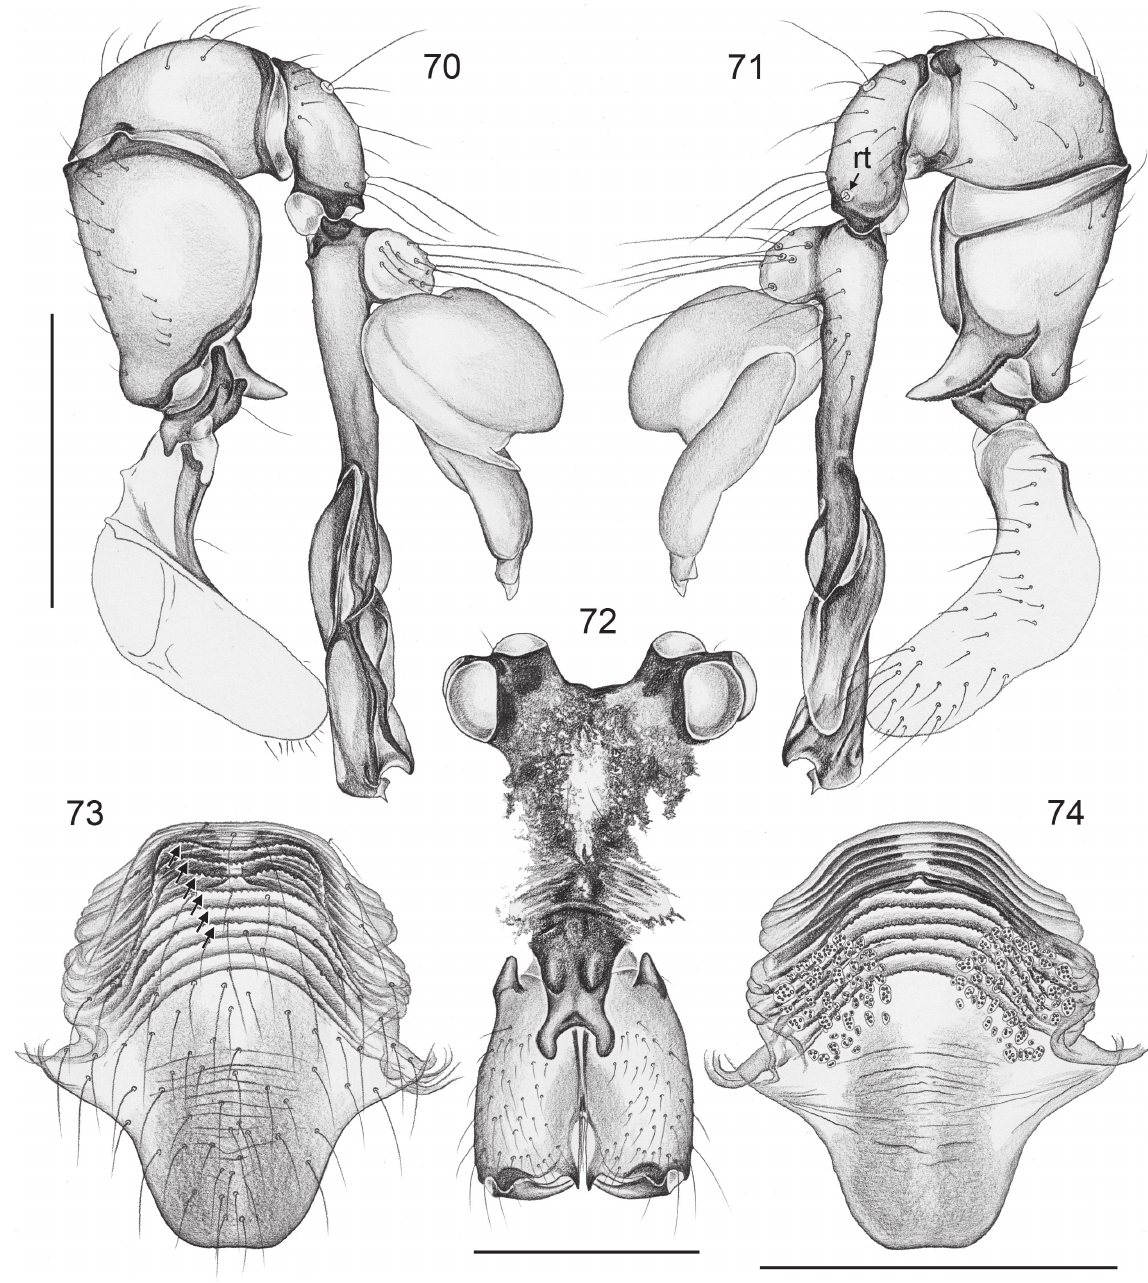
Figs 70–74. Aetana paragua Huber, sp. nov. 70–71 . Left male palp, prolateral and retrolateral views. 72 . Male prosoma, frontal view. 73–74 . Cleared female genitalia, ventral and dorsal views (arrows point at serrated ridges). rt = retrolateral trichobothrium. Scale lines: